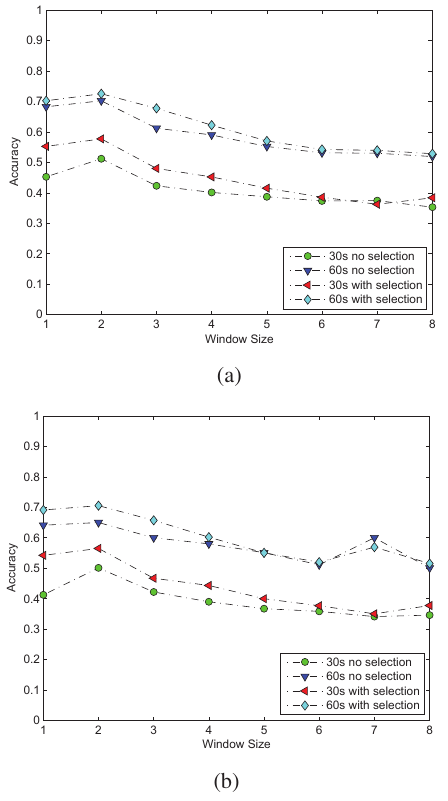
Figure 15: Performance comparison on different window sizes using 30s and 60s strategies without and with tag selection in (a) lab environment, (b) bedroom environment